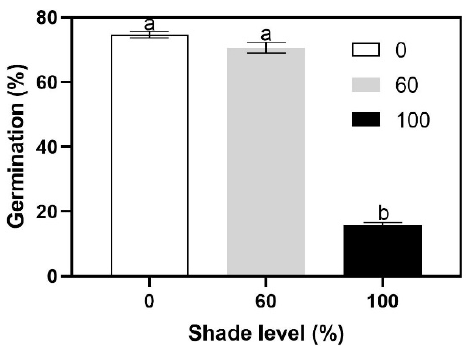
Figure 2. Eucalyptus benthamii seed germination under three levels of shade in the greenhouse. Error bars indicate the standard error. Means sharing a letter are not significantly different (Tukey’s HSD, α = 0.05).